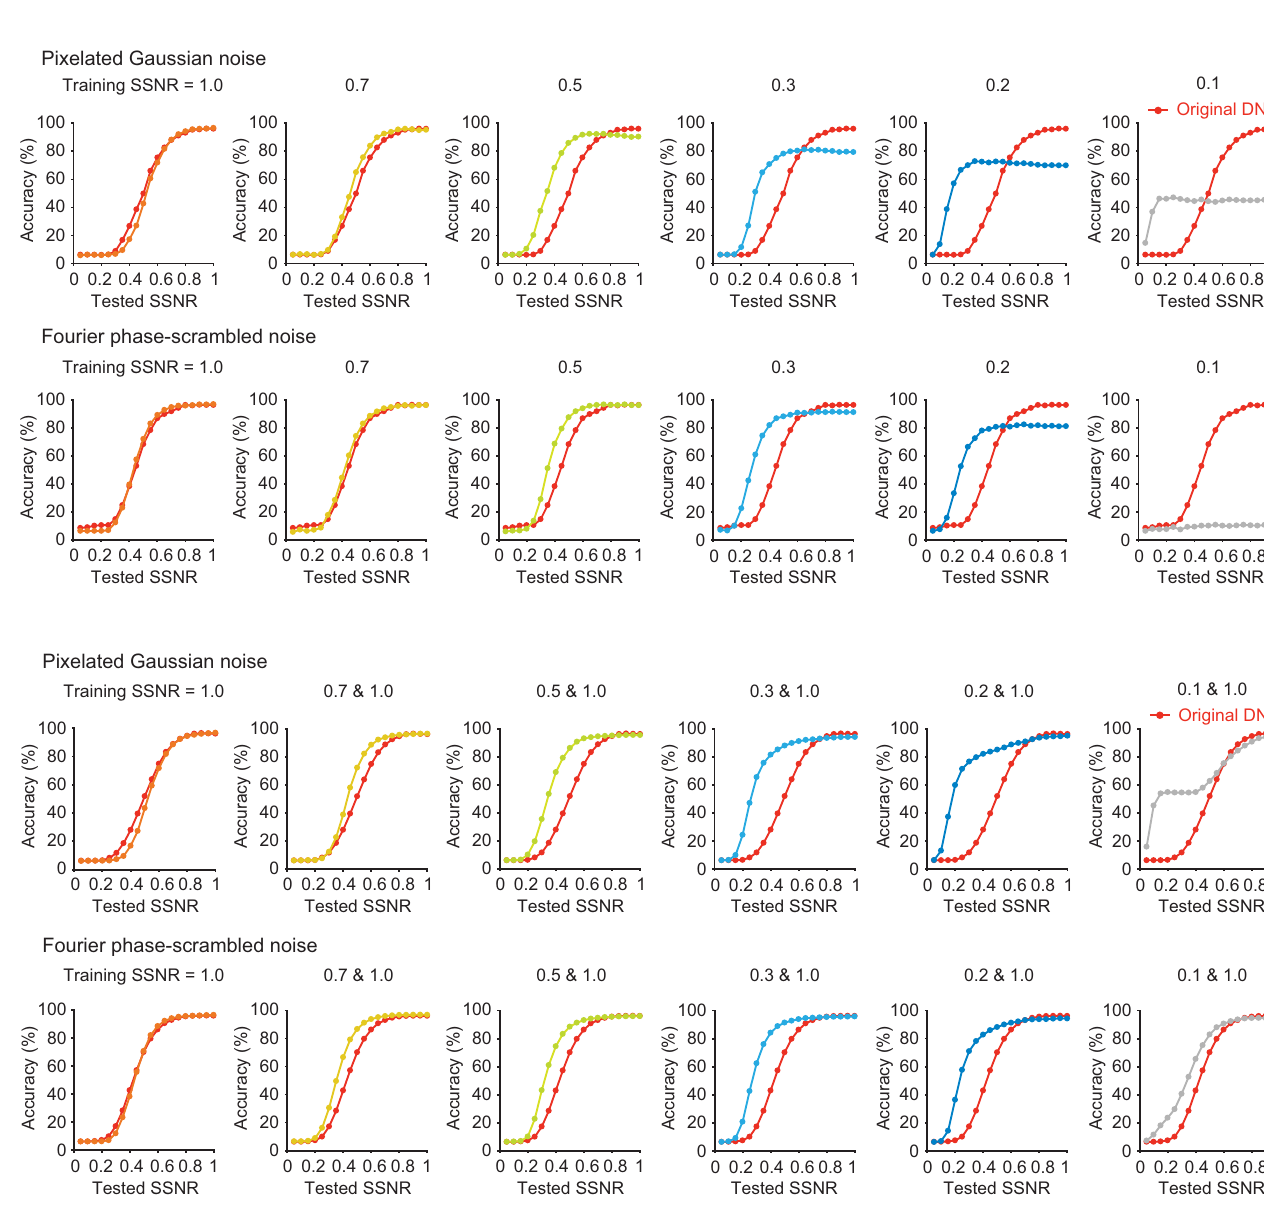
Fig 3. Effects of training DNNs with objects in noise. (a) Impact of training VGG-19 with object images presented at a single SSNR level (1.0, 0.7, 0.5, 0.3, 0.2, or 0.1) when evaluated with novel test images presented at multiple SSNR levels. Accuracy of pretrained VGG-19 (red curve) serves as a reference in each plot. (b) Impact of training VGG-19 with a combination of noise-free images (SSNR 1.0) and noisy images at a specified SSNR level. Data are available at https://osf.io/bxr2v/. DNN, deep neural network; SSNR, signal-to-signal-plus-noise ratio.